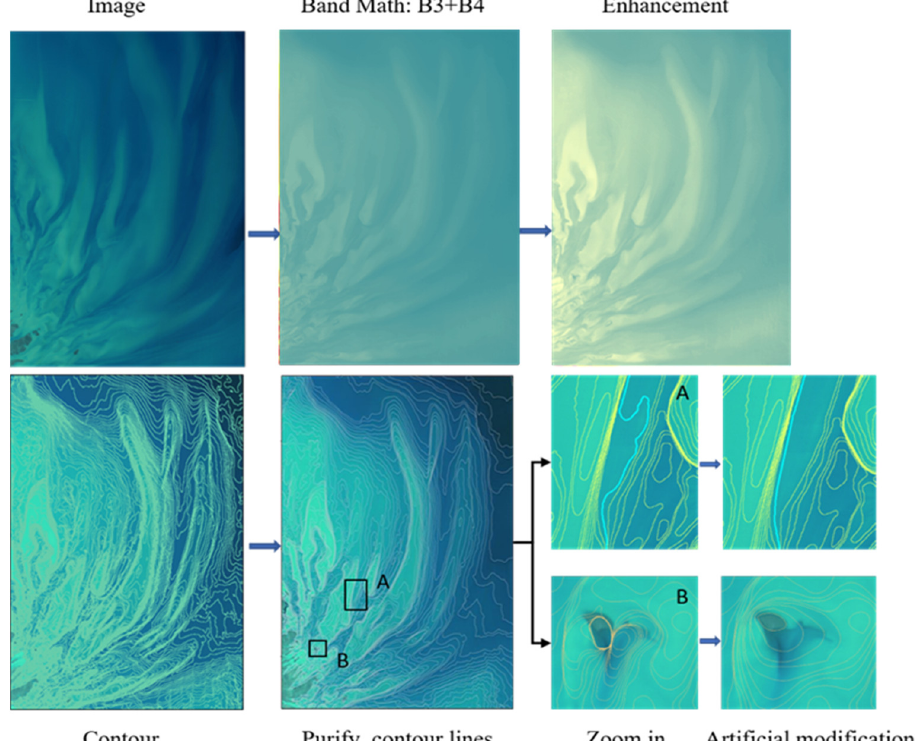
Figure 4. Sand ridge line extraction flow diagram.